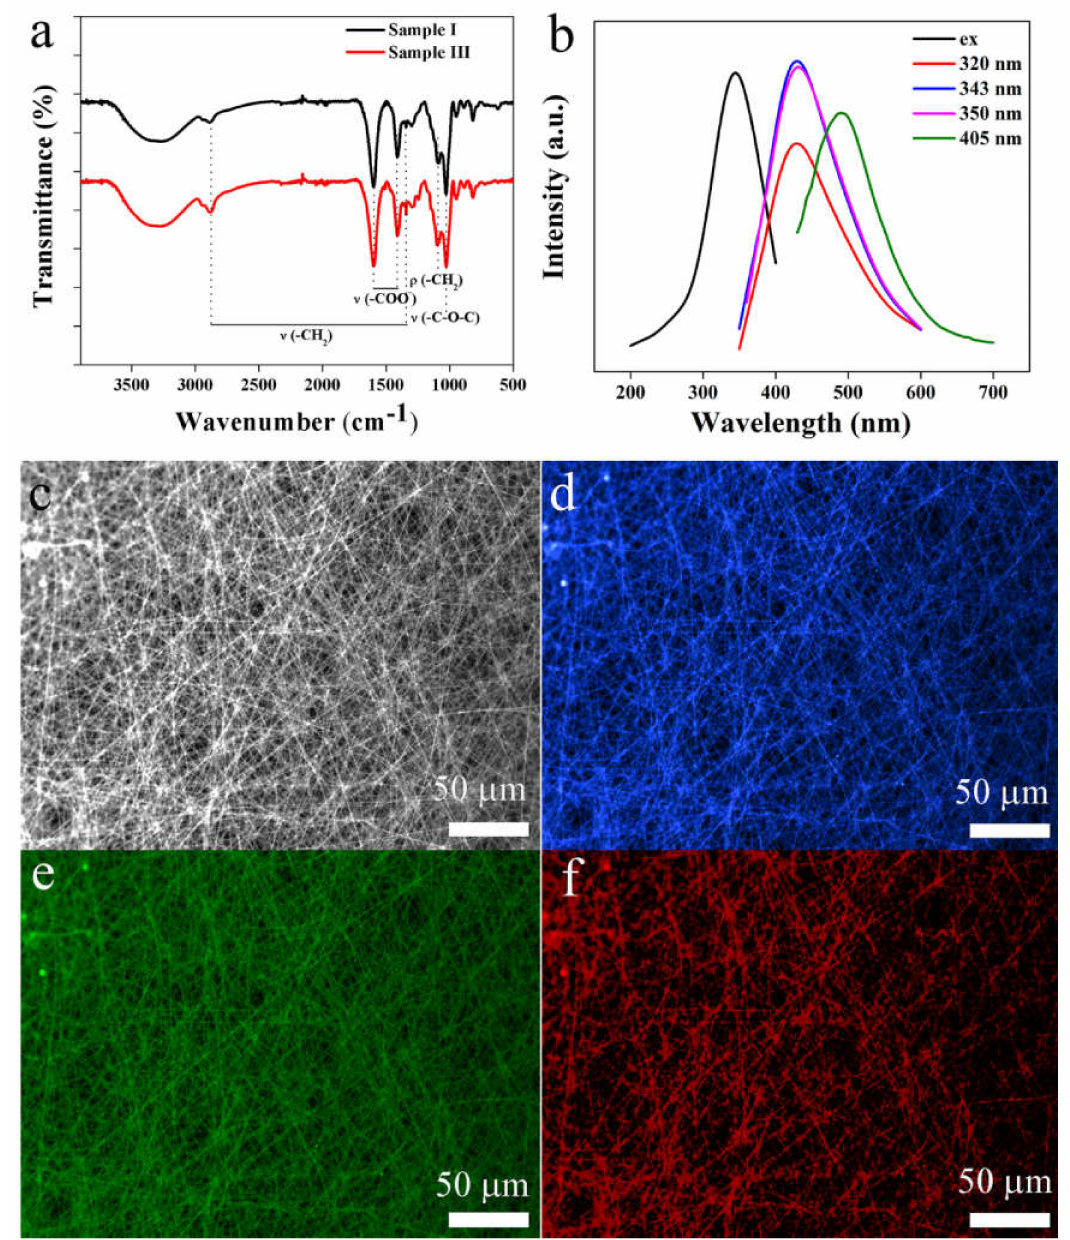
Figure 3. ( a ) FT-IR spectra of samples I and III; ( b ) Fluorescent spectra of sample III, including excitation and emission spectra excited at 320 nm, 343 nm, 350 nm and 405 nm; c – f : CLSM images of sample III with ( c ) no excitation, and at ( d ) 405 nm, ( e ) 488 nm, and ( f ) 561 nm,